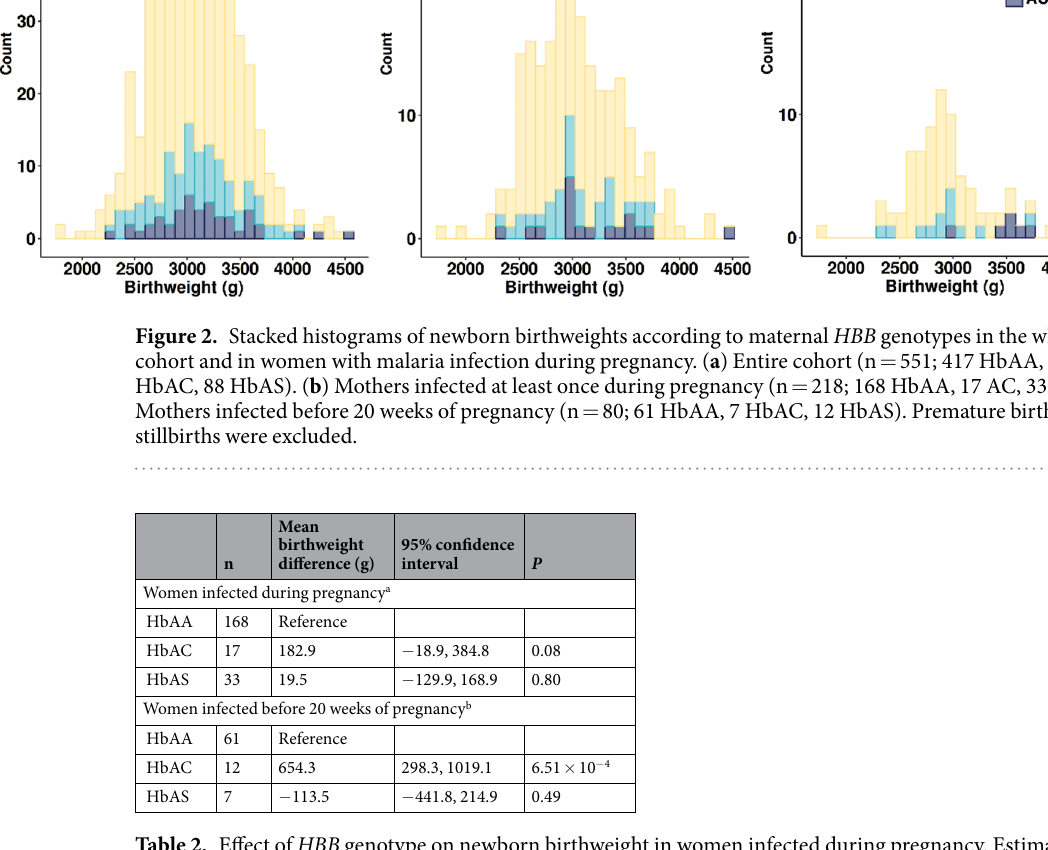
Table 2. Effect of HBB genotype on newborn birthweight in women infected during pregnancy. Estimates of mean birthweight were obtained using a multiple linear model. a Model was adjusted on gestational age at delivery, parity, fetal sex, season at the beginning of pregnancy, ethnic group, and malaria infection at inclusion. Covariates retained in the model were those associated with outcome at p < 0.20. b Model was adjusted on gestational age at delivery, parity, fetal sex, season at the beginning of pregnancy, and ethnic group. All covariates were associated with outcome at p < 0.20, except parity. Ethnicity was forced in the model as it is a main determinant of